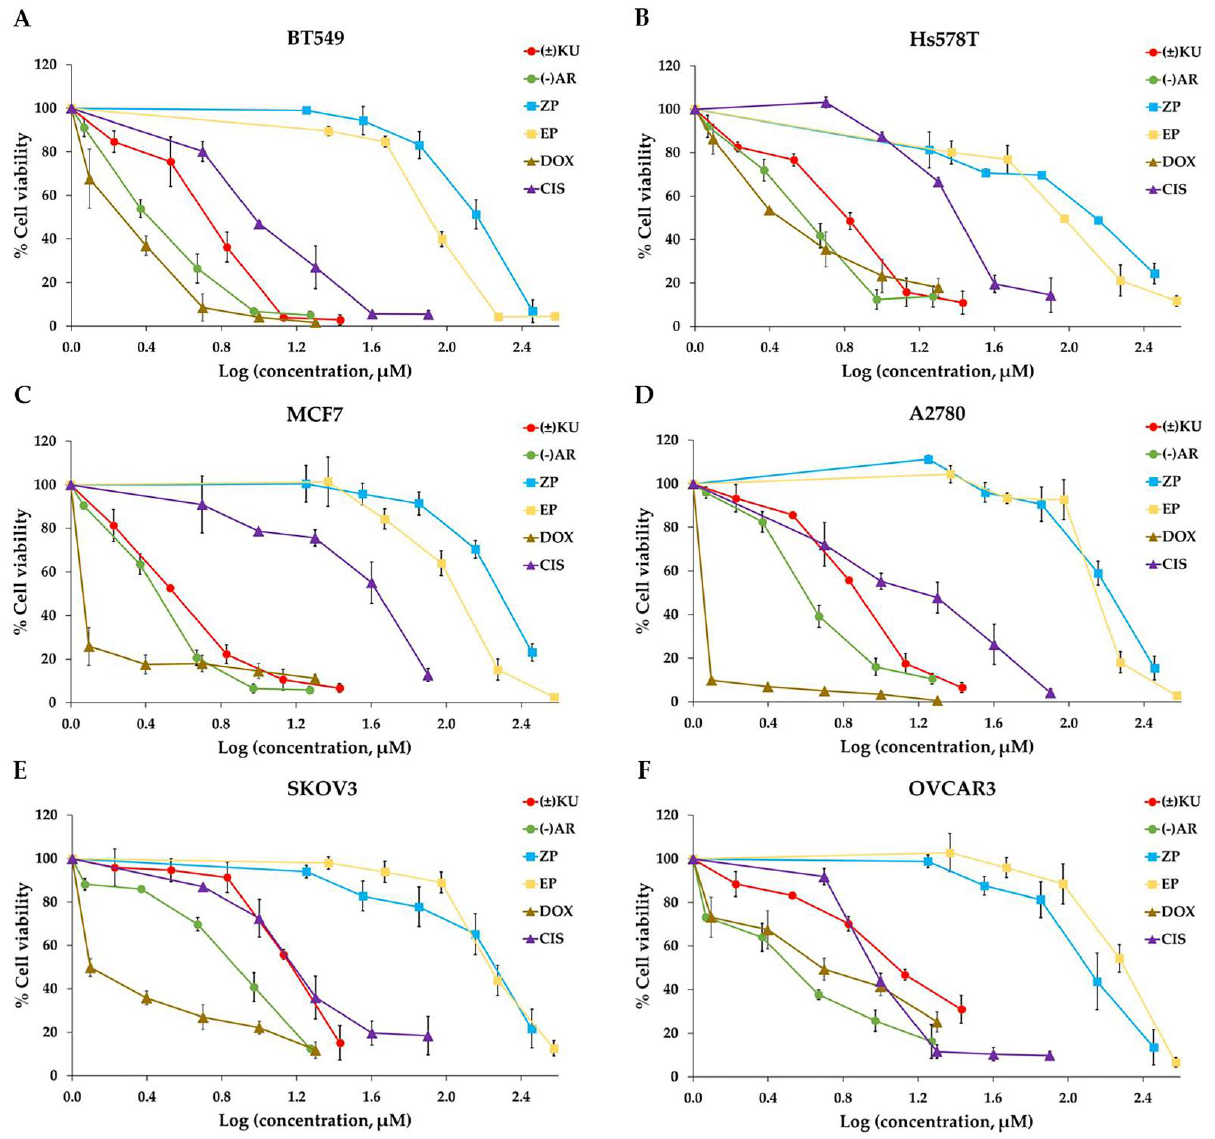
Figure 2 . Cell viabilities of breast and ovarian cancer cells after exposure to, ( ± ) KU , ( − ) AR, ZP, EP, DOX and CIS . Cells were seeded on 96 - well plates for 24 h, followed by the treatment of indicated compounds for 72 h . Cell viability was determined by MTT assay . Graph representing the percentage of cell viabilities on breast cancer cells, including ( A ) BT549, ( B ) Hs578T, ( C ) MCF7 and ovarian cancer cell lines, including ( D ) A2780, ( E ) SKOV3, ( F ) OVCAR3 . All data are represented as mean ± SD with three independent experiments . ( ± ) KU, trans -( ± )- kusunokinin; ( − ) AR, trans -( − )- arctiin; ZP, zopolrestat; EP, epalrestat; DOX, doxorubicin; CIS, cisplatin .